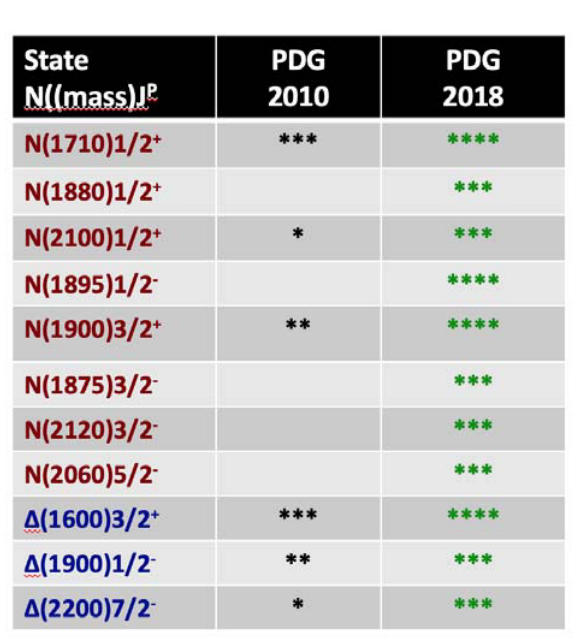
Fig. 4 Evidence for 11 N and Δ states in RPP 2010 compared with RPP 2018 [12].